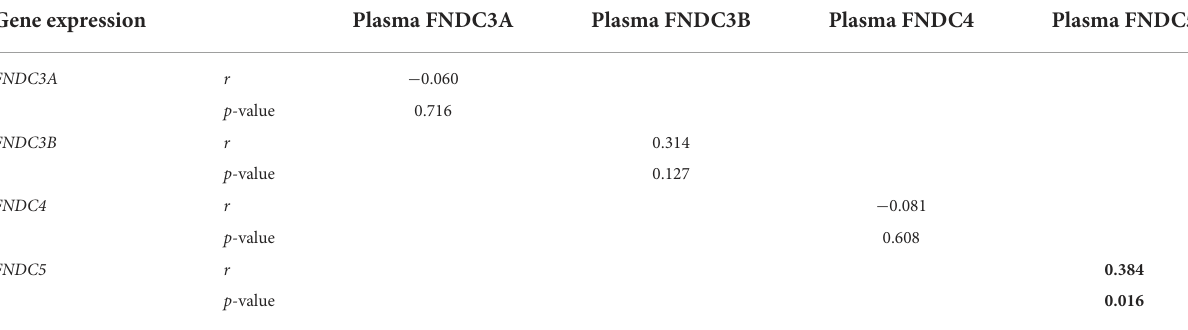
TABLE 8 Spearman correlation coefficients (r) between FNDCs plasma concentration and FNDCs genes expression in adipose tissue by combining data from HNEB and LNEB animals during the peripartum period (4WAP − 16WPP). Gene expression Plasma FNDC3A Plasma FNDC3B Plasma